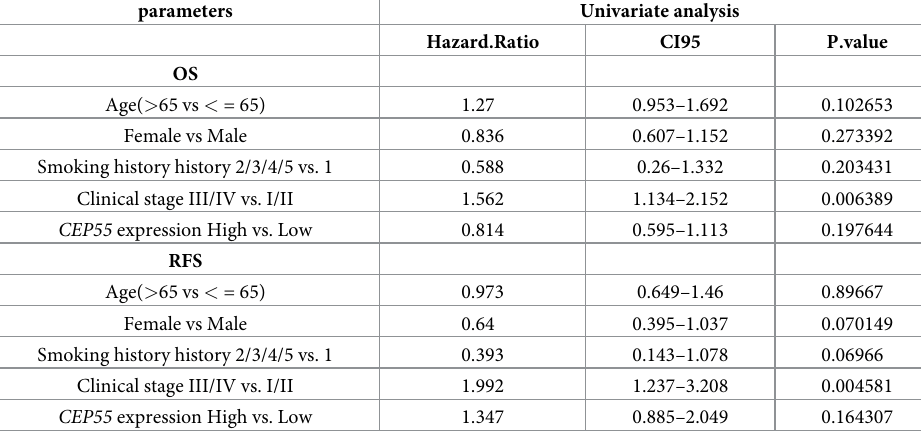
Table 4. Univariate analyses of OS/RFS in patients with primary LUSC.